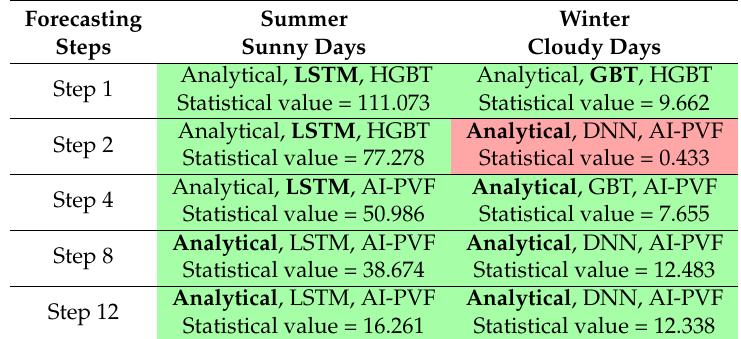
Table 7. Results of Kruskal-Wallis statistical test performed for the sunny days subperiod of the summer season and the cloudy days subperiod of the winter season for all forecasting horizons. The rejection of the null hypothesis is highlighted by green color, while its acceptance by red. The best performing model in each case in highlighted by bold